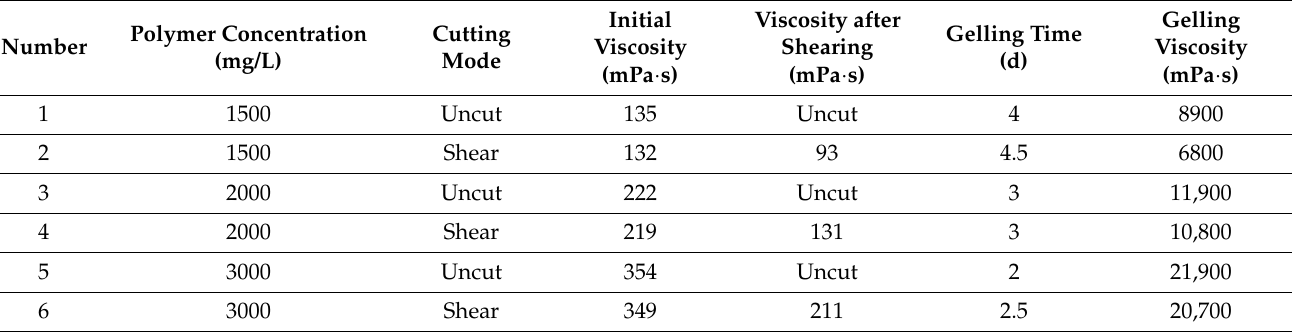
Table 5. The effect of shear on the performance of the system.